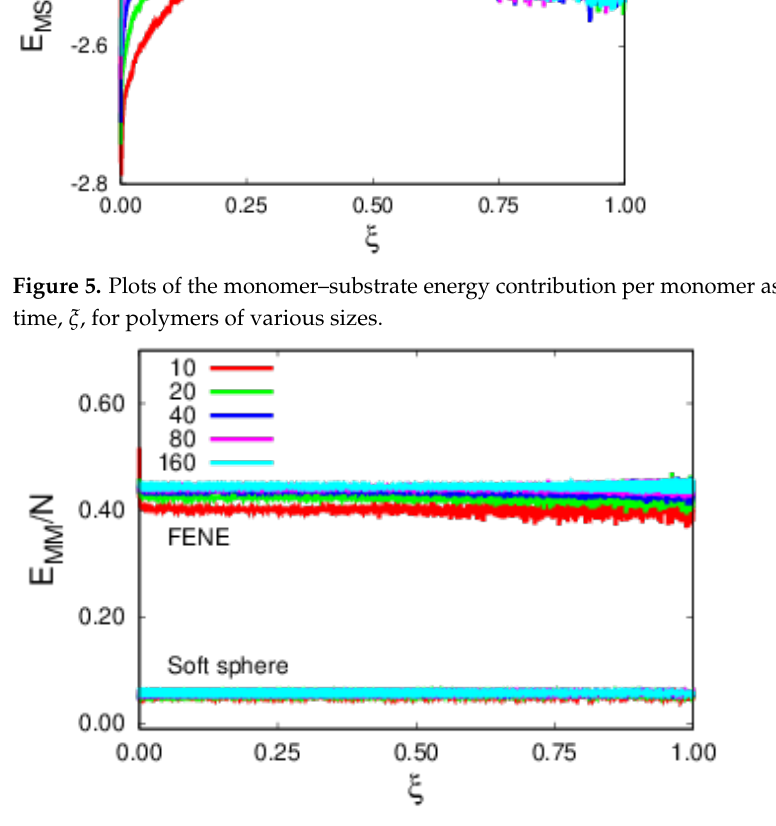
Figure 6. Plots of the two repulsive energy contributions, namely, soft-sphere and FENE, per monomer, as a function of rescaled time, ξ , for polymers of various